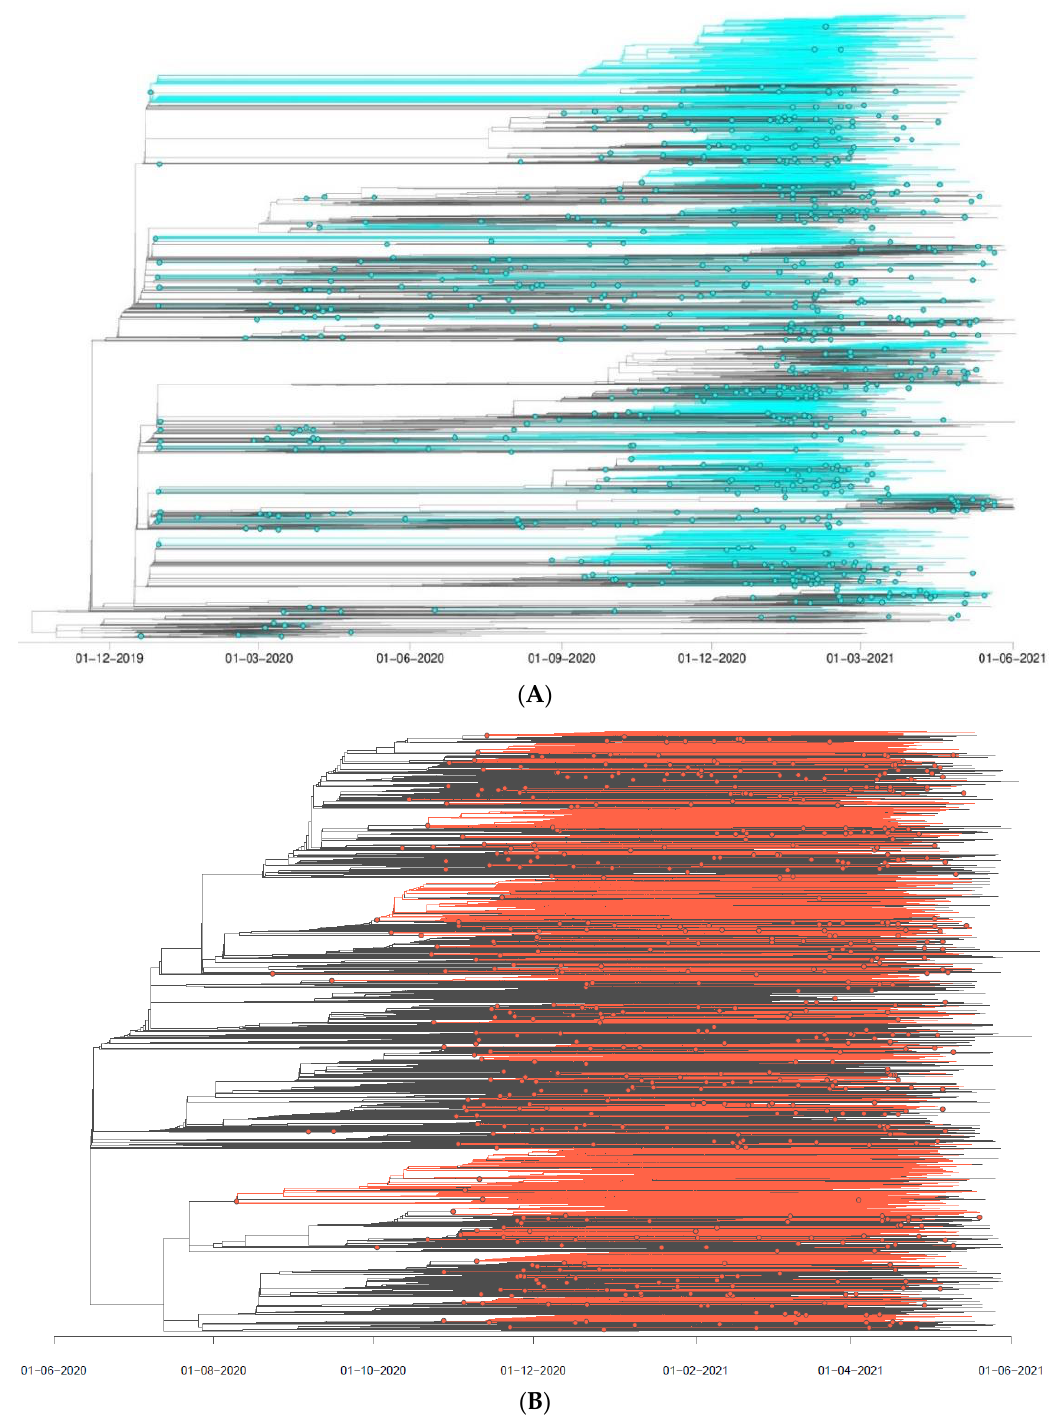
Figure 3. Time scaled phylogenetic tree of non-Alpha ( A ) and Alpha ( B ) sequences with identified PL-DE-Interreg clusters. A cluster is represented as a phylogenetic clade likely corresponding to a distinct introduction into the studied Polish–German frontier area. We outlined these clusters by implementing a simplistic discrete phylogeographic reconstruction along the time-scaled phyloge- netic tree. Ancestral locations are identified by labelling each node in the tree as PL-DE-Interreg or outside-PL-DE-Interreg, only considering these two potential positions. On the phylogenetic tree, non-Alpha lineages circulating in the Polish–German border region are highlighted in cyan ( A ) and red ( B ). Nodes in cyan match the most ancestral node of each PL-DE-Interreg